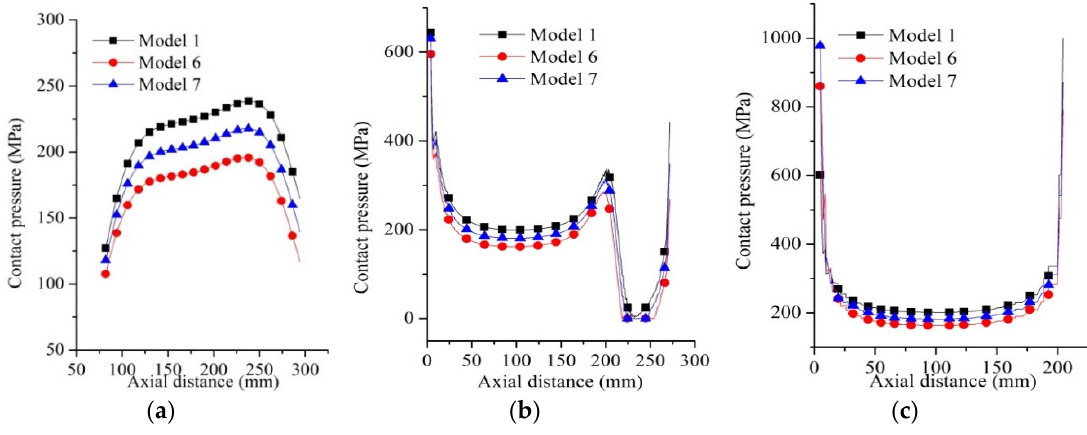
Figure 8. Distribution of the contact pressure on each mating surface under different propel strokes. ( a ) Mating surfaces of shaft and sleeve; ( b ) mating surfaces of sleeve and inner ring; ( c ) mating surfaces of inner ring and outer ring.